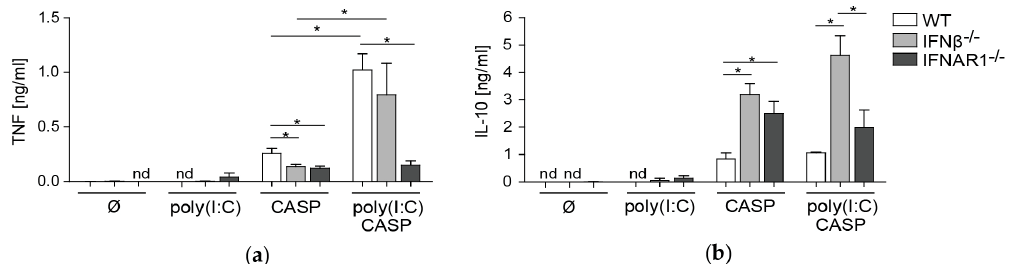
Figure 5. Di ff erential e ff ects of poly(I:C) pre-treatment on pro- vs. anti-inflammatory cytokine levels in Figure 5. Differential effects of poly(I:C) pre-treatment on pro- vs. anti-inflammatory cytokine levels the peritoneal cavity during CASP. Mice were treated as described in Figures 2 and 3. Peritoneal fluid was harvested before CASP ( ∅ ) or 12 h thereafter. TNF ( a ) and IL-10 ( b ) concentrations in the peritoneal fluid were determined by ELISA. n = 5–7 animals per group. Error bars indicate SD. * p < 0.05 using Student’s t 0.05 using Student’s t -test.